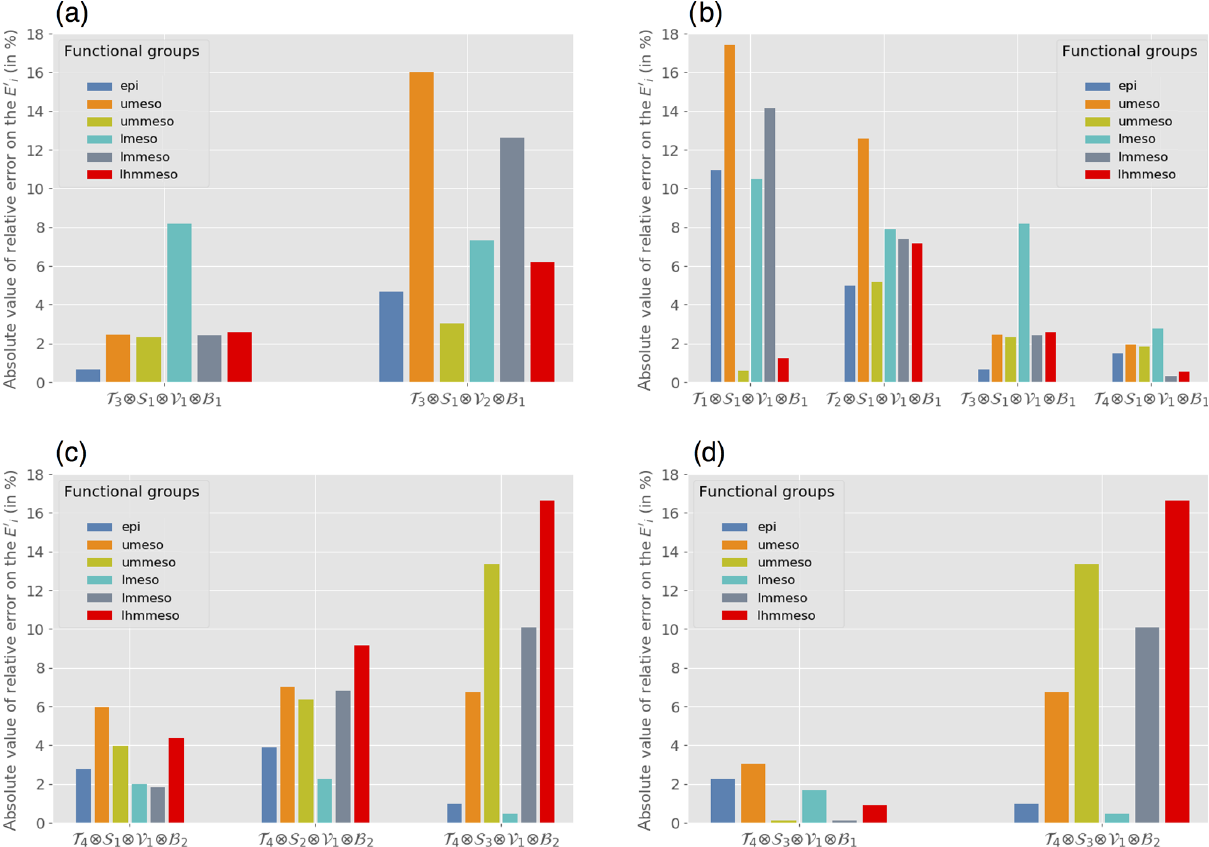
Figure 3. Mean relative error ( E r in %, Eq. 9) on each E (cid:48) coefficients for (a) Exp. 1c and d, which present the following tested regimes: i high versus low velocities in temperate temperatures, weak-stratification regimes and bloom regimes; (b) Exp. 2a, 2b, 2c and 2d, which compares polar, subpolar, temperate and tropical temperatures in weak-stratification, low-velocity and bloom regimes; (c) Exp. 3a, b and c, which compares weak, intermediate and high stratification in tropical-temperature, low-velocity and no-bloom regimes; and (d) Exp. 4c and d: bloom versus no-bloom regimes in tropical temperatures, strong stratification and low